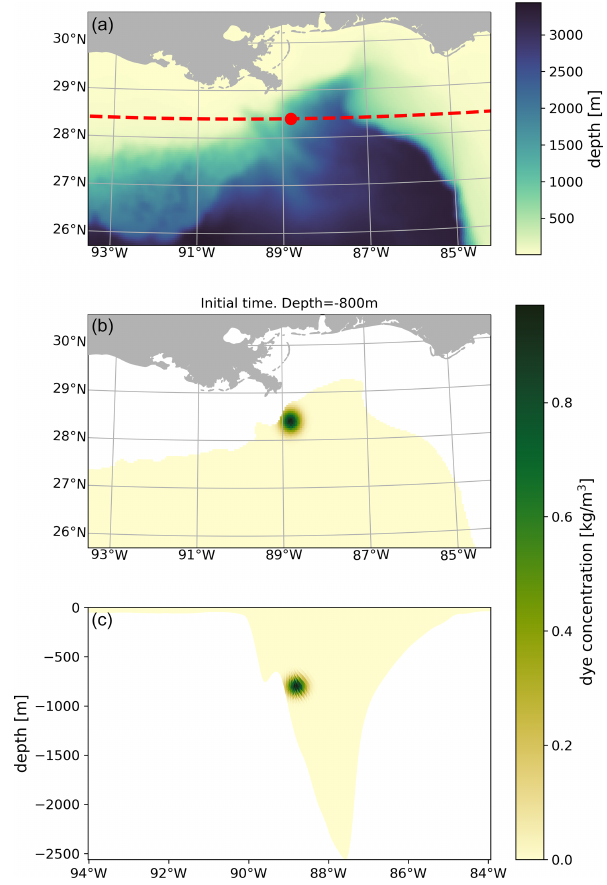
Figure 2. Second experiment: discrete Gaussian blob of dye at 800m depth. Subplots show the domain and bathymetry (a) , the dye slice at 800m depth (b) , and the vertical cross section of the dye field (c) across the red dashed line in panel (a) . The red circle in panel (a) indicates the center of the dye